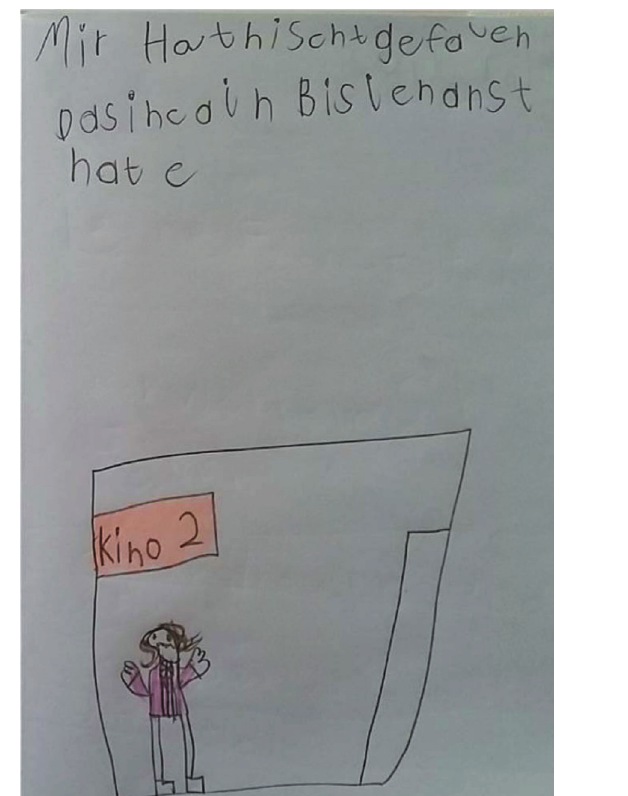
Figure 7: Primary school child’s commentary on the cinema visit: ‘Cinema 2, I didn’t like it that I was scared a little